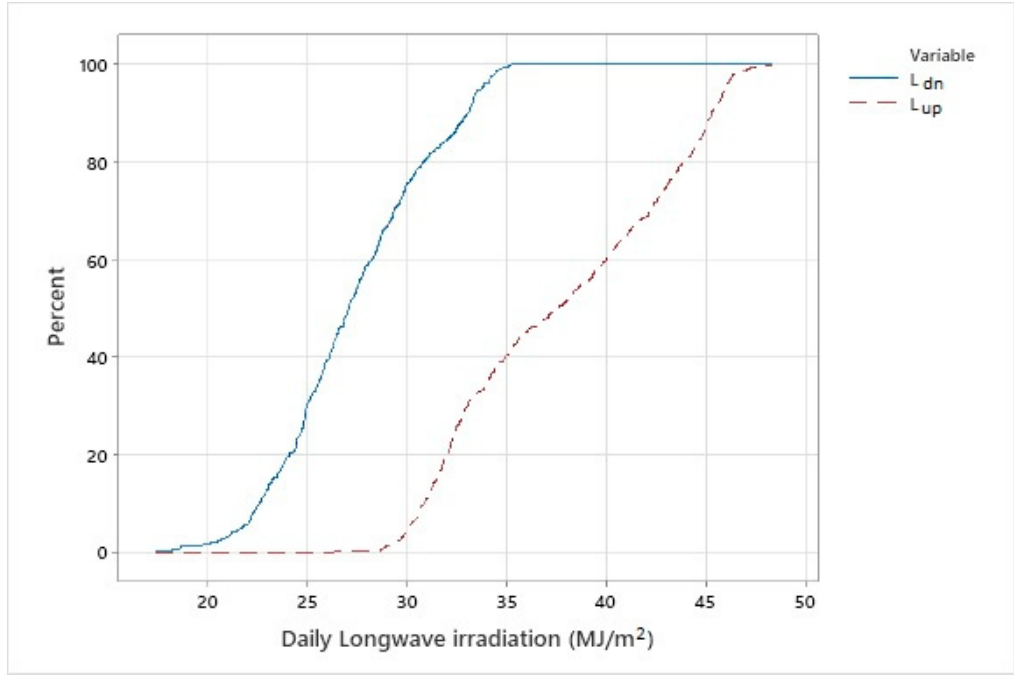
Figure 14. Cumulative density function (CDF) of the daily downward ( L dn ) and upward ( L up ) longwave irradiation (MJ m − 2 ) at Athalassa.